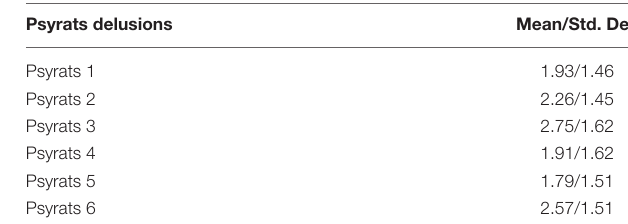
TABLE 3 | Characterization of the current dimensions of delusions according to